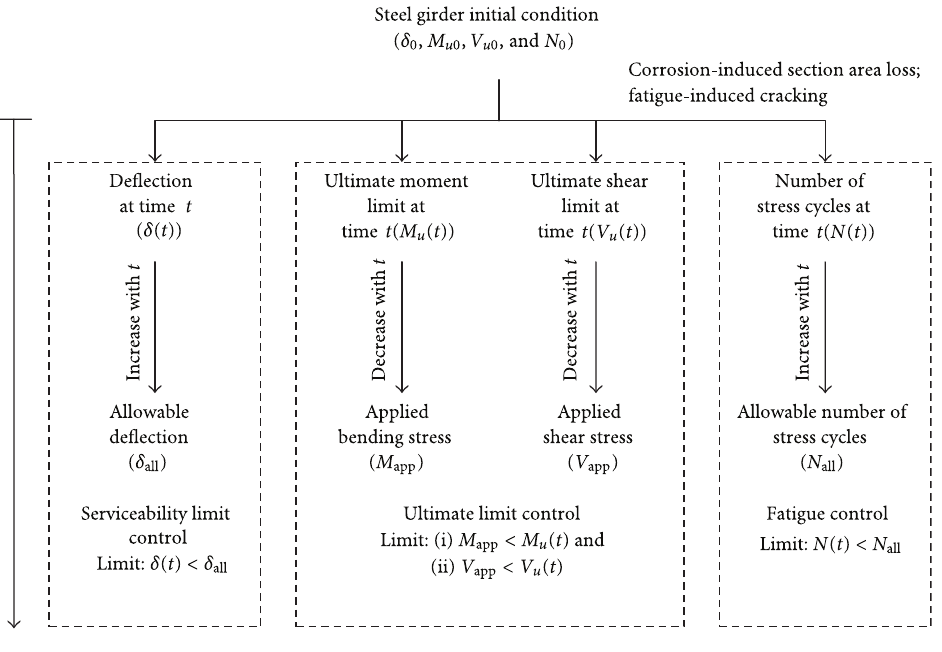
Figure 2: Integrated LCM strategy on steel bridge girders due to corrosion and